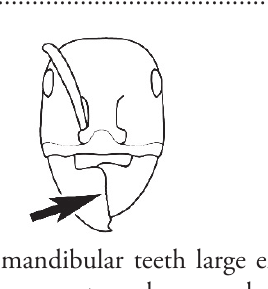
Mandible edentate or with minute crenulations along its masticatory margin; head capsule elongate-rectangular; anterior margin of clypeus straight; PF 3,4 ( JDM 1032 ) (inland areas of least QLD, SA and WA) (Fig. 97a–g)